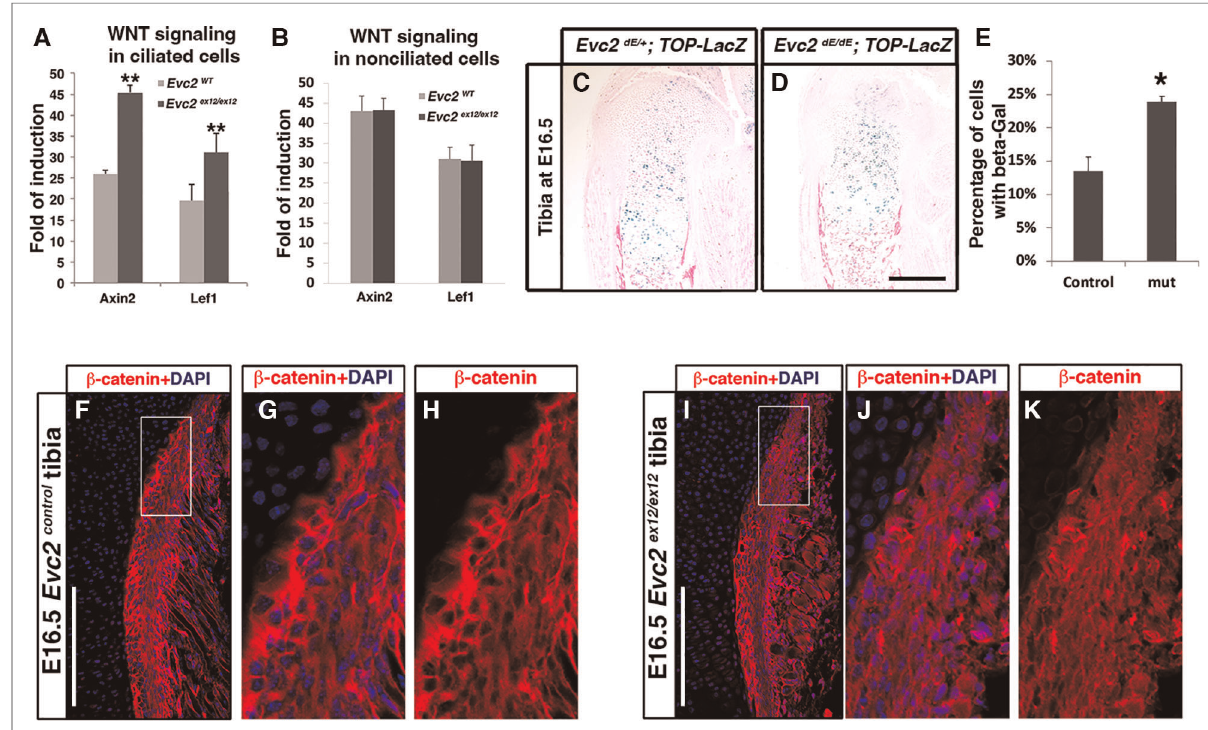
FIGURE 7 Ciliated ( A ) and non-ciliated ( B ) MEFs from controls or Evc2 mutants were treated with WNT3A. The induction of WNT signaling was calculated and shown. WNT signaling within tibia were evaluated with a TOP-gal reporter in controls ( C ) and Evc2 mutants ( D ). The number of cells positive for beta- gal were quanti fi ed and shown in ( E ) ( n =3, p <0.01). E16.5 tibia from controls ( F – H ) and Evc2 mutants ( I – K ) were immunolabeled with beta-catenin. White boxes in F and I were shown as enlarged perichondrium for controls ( G,H ) or Evc2 mutants ( J,K ). Bar=100